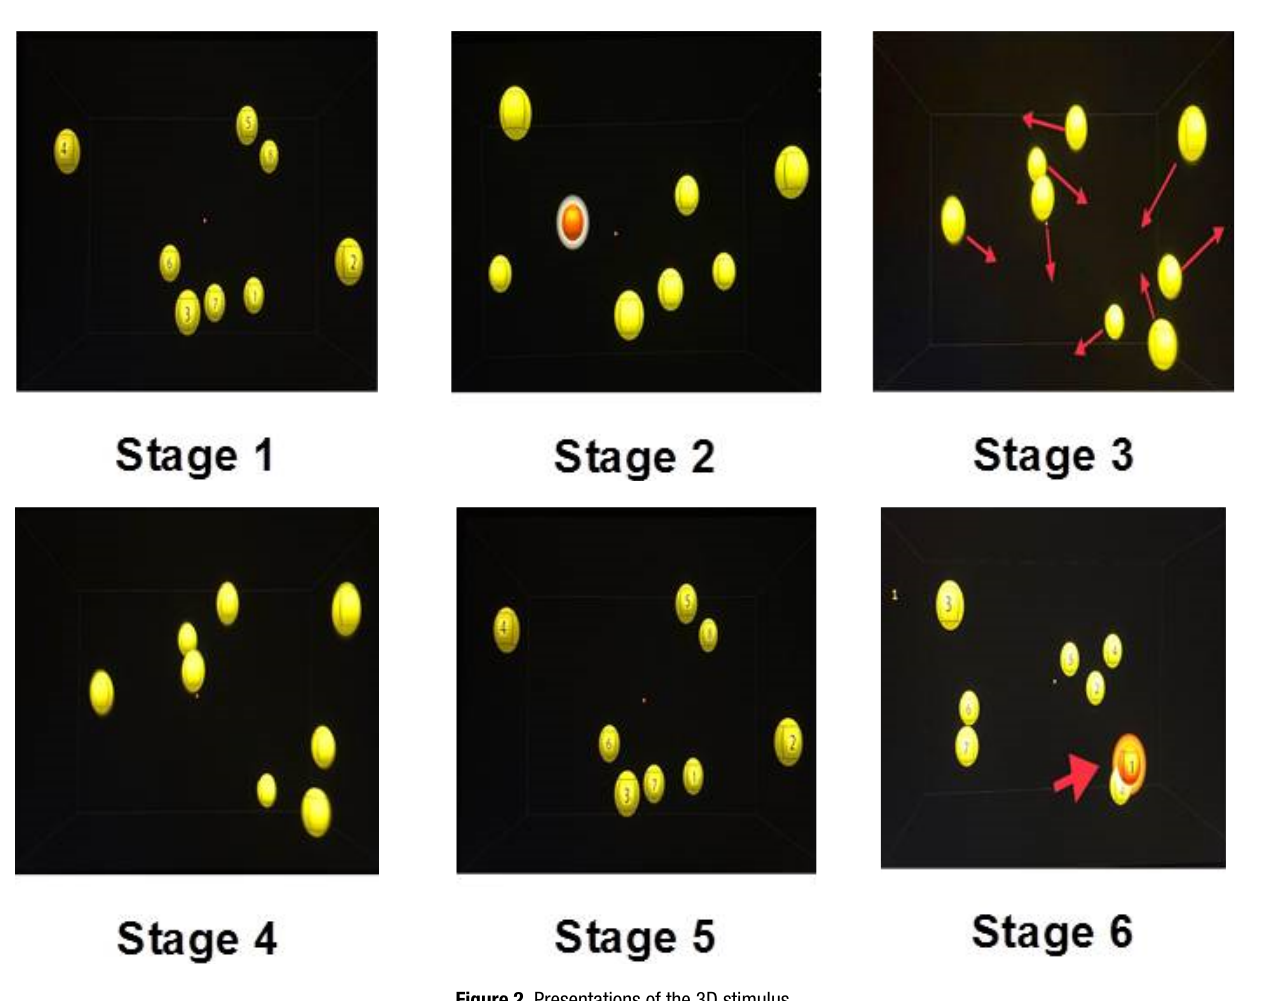
Figure 2. Presentations of the 3D